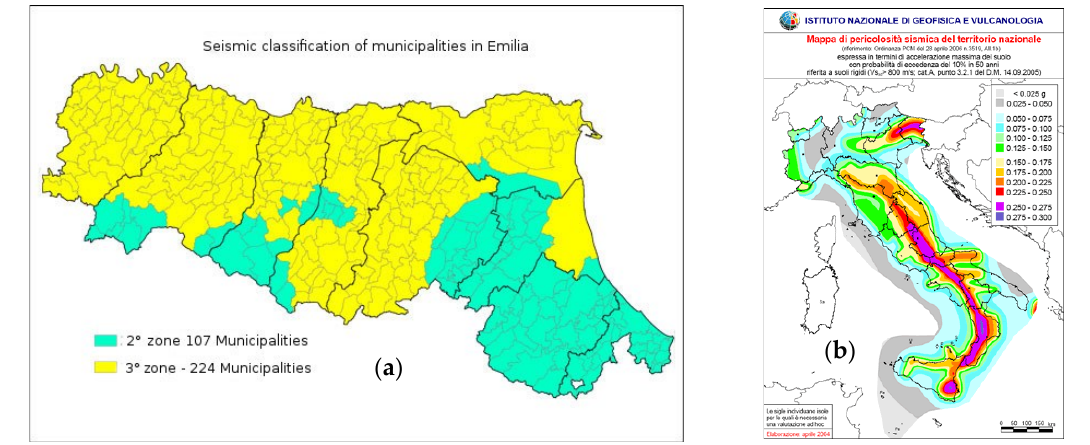
Figure 2. ( a ) Seismic classification of municipalities in Emilia (https://ambiente.regione.emilia-romagna.it/en/geologia/seismic-risk/seismic-classification, accessed 26 January 2022). ( b ) Seismic Hazard Map of Italy (free source from INGV webpage http://zonesismiche.mi.ingv.it/, accessed on 26 January 2022).